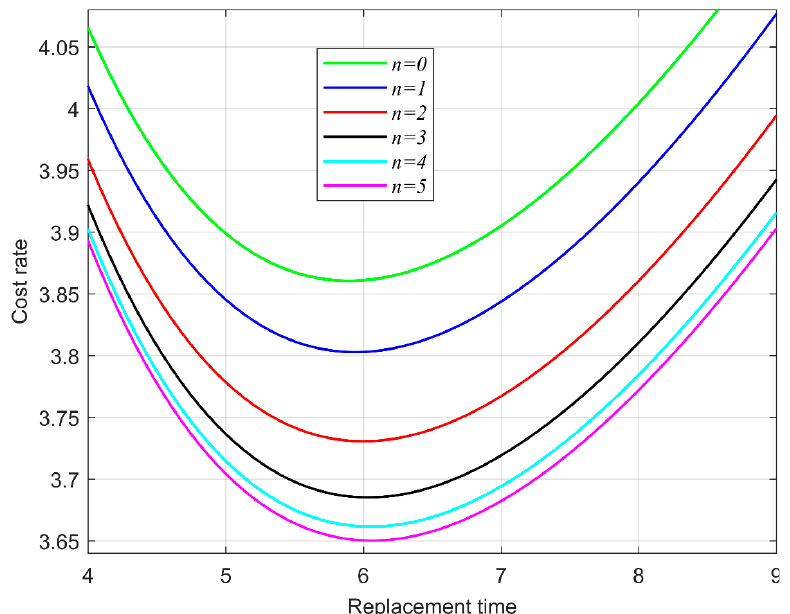
Figure 3. The optimality of the post-warranty maintenance policy.